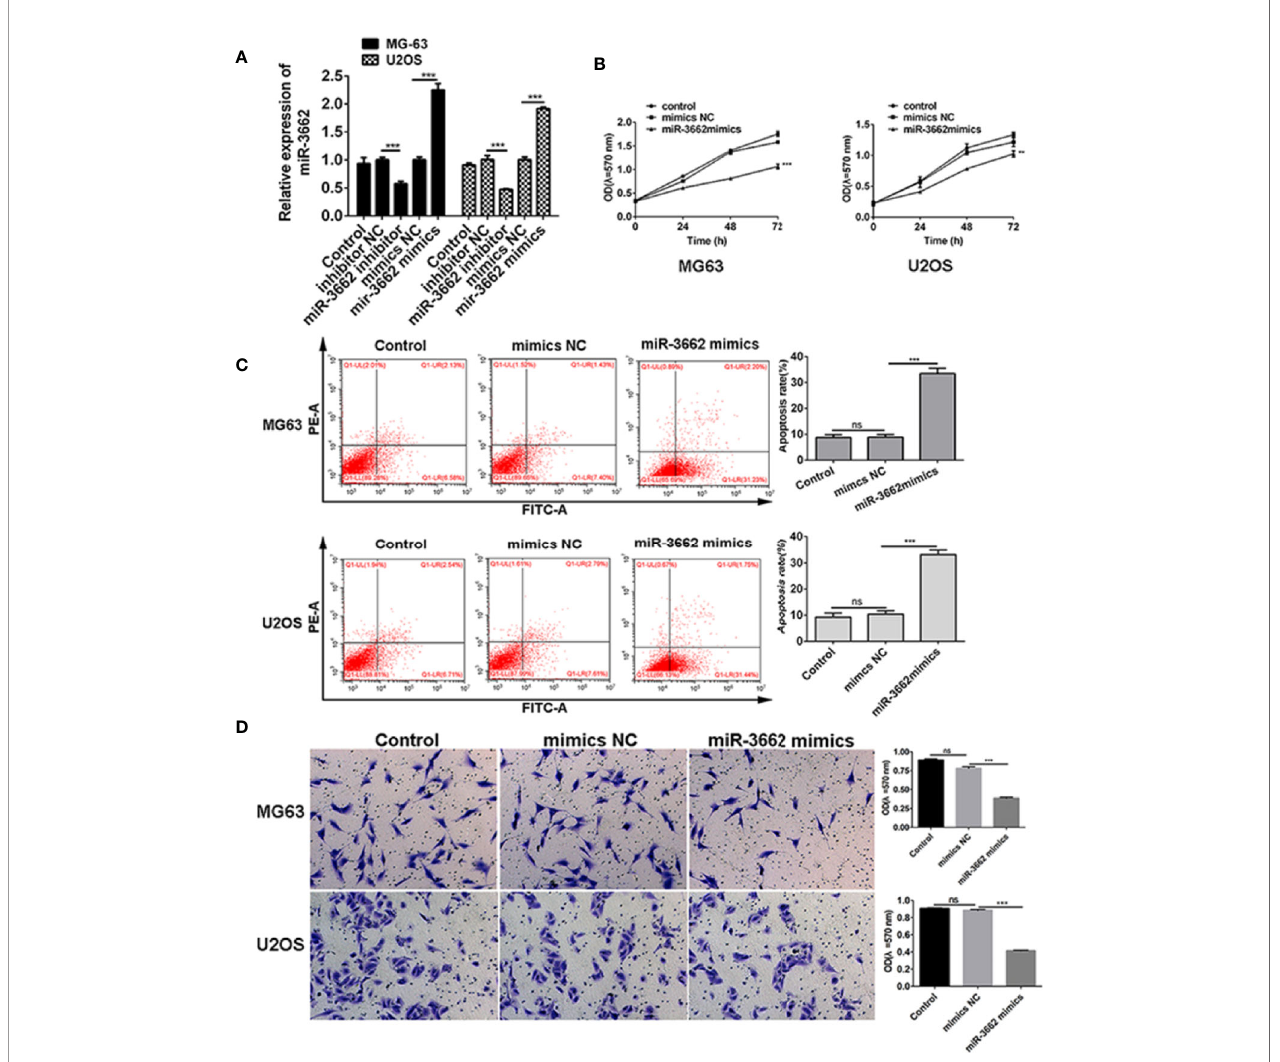
FIGURE 3 | miR-3662 mimics inhibit osteosarcoma cell proliferation, promote cell apoptosis, and inhibit cell invasion. (A) qRT-PCR was used to verify the transformation ef fi ciency of miR-3662 mimics and inhibitor in osteosarcoma cells MG-63 and U2OS. (B) MTT assay was used to detect the effects of miR-3662 mimics on the proliferation of osteosarcoma cells MG-63 and U2OS at 24, 48 and 72 hours after transfection. (C) Flow cytometry was used to detect the effect of miR-3662 mimics on apoptosis of osteosarcoma cells MG-63 and U2OS at 48 hours after transfection. (D) Transwell assay was used to detect the effects of miR- 3662 mimics on the invasion of osteosarcoma cells MG-63 and U2OS at 48 hours after transfection. Data are presented as the mean ± standard deviation of three independent experiments, ns, not signi fi cant, ** p < 0.01, *** p < 0.001 vs. shNC